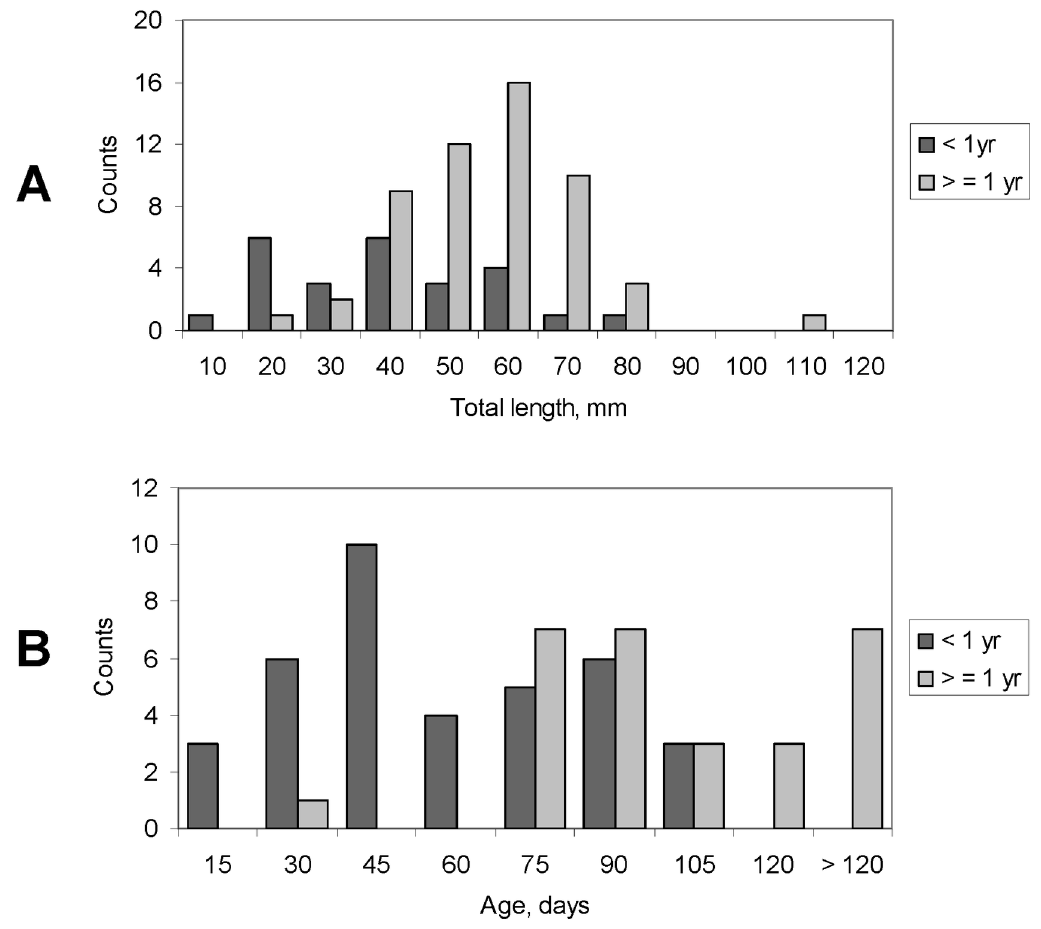
Figure 8. Frequency histograms of back-calculated humpback chub size (A) and age (B) at egress from the Little Colorado River, separated by age at time of